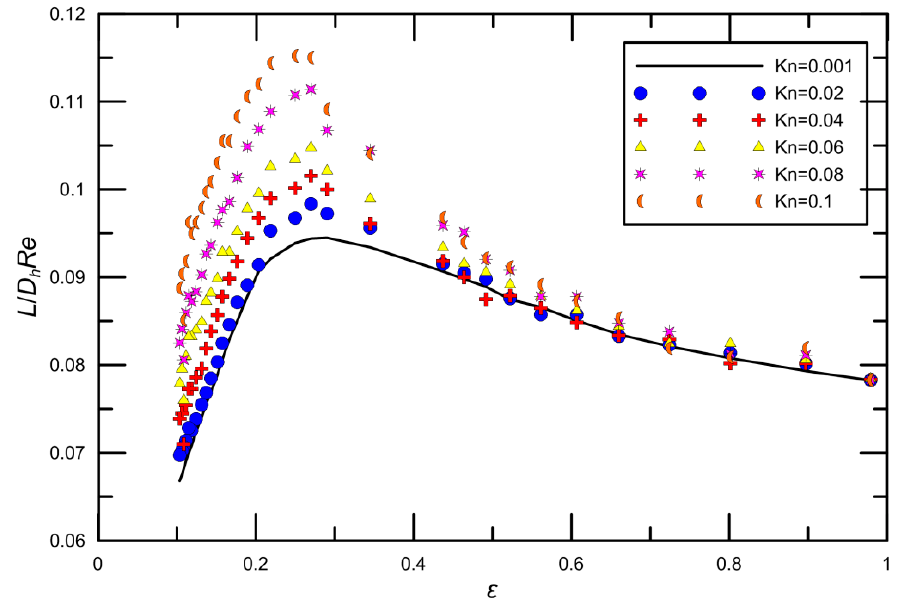
Figure 9. Variation of entrance length with channel aspect ratio ε at different Kn values.